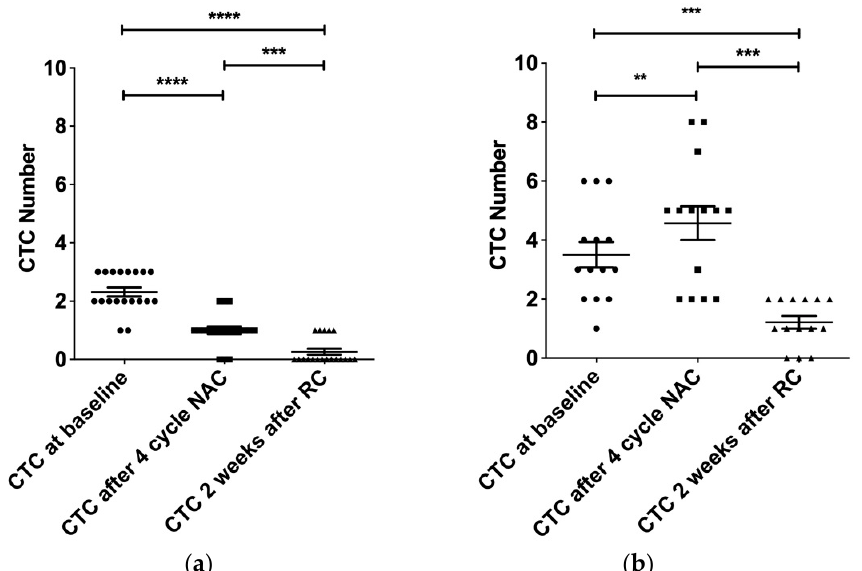
Figure 2. Time course analysis of CTC levels in bladder cancer. CTC levels were evaluated in 33 MIBC patients before starting treatment and after four cycles of NAC and two weeks after RC. Number of CTCs/7.5 mL is shown on the plots. ( a ) Disease control group; ( b ) Progressive disease group;